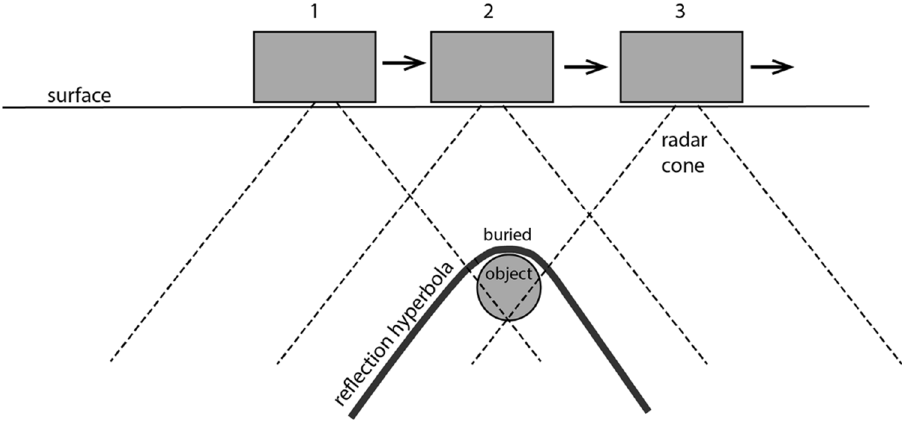
Figure 1. Diagram showing the hyperbola created in a transect profile (radargram) when the antenna crosses a buried object which is farther (1) then closer (2) and then farther (3) from the object. Radar wave velocity changes for different subsurface materials are determined by physical and chemical properties of the material [4] that determine their electromagnetic properties, or relative dielectric permittivity (RDP). The larger the RDP contrast between two materials at an interface, the stronger the return wave amplitude from that depth.